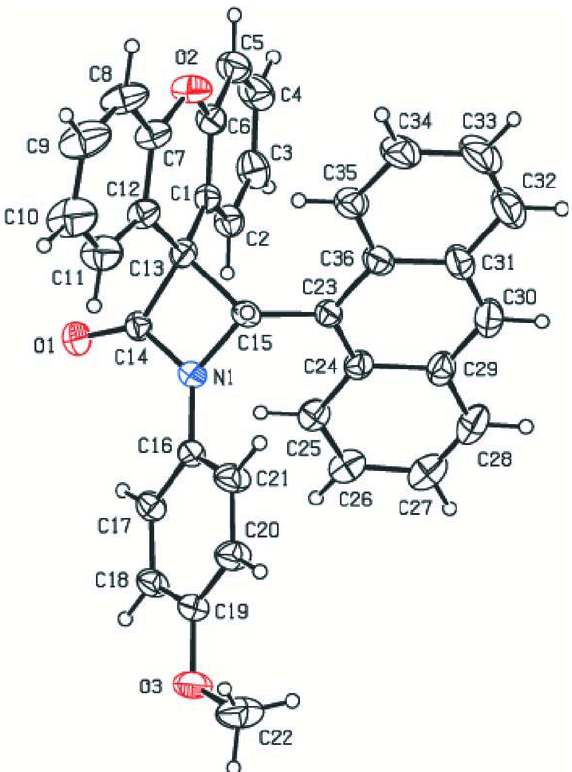
Figure 1. X-ray crystal structure of 2a